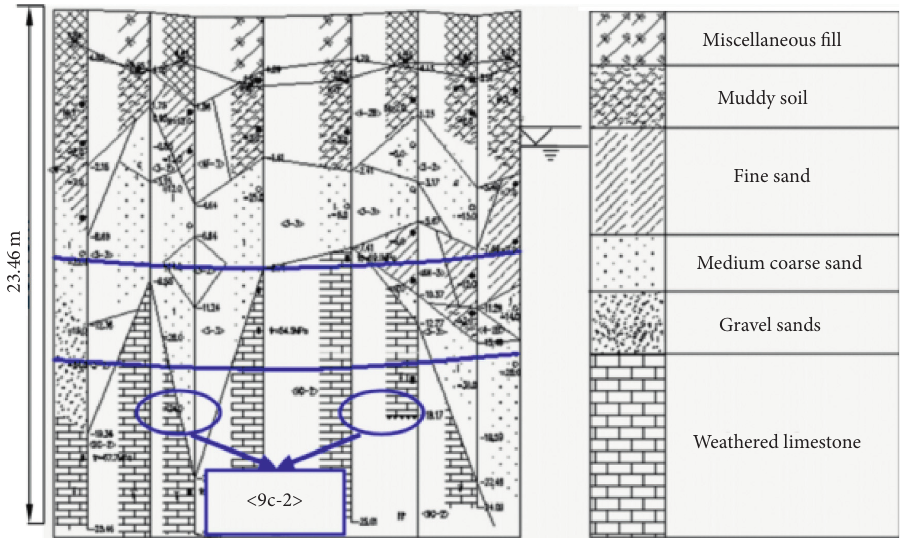
Figure 1: Geological profile